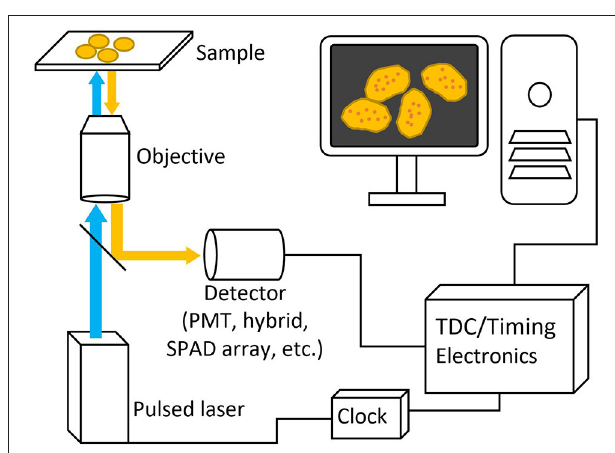
FIGURE 3 | Basic schematic picture of a generalized FLIM system. Pulsed excitation light passes through the microscope to the sample and the excitation light travels back through and is deflected to a detector with a dichroic mirror. Both laser and detector setups are then connected to timing electronics for lifetime